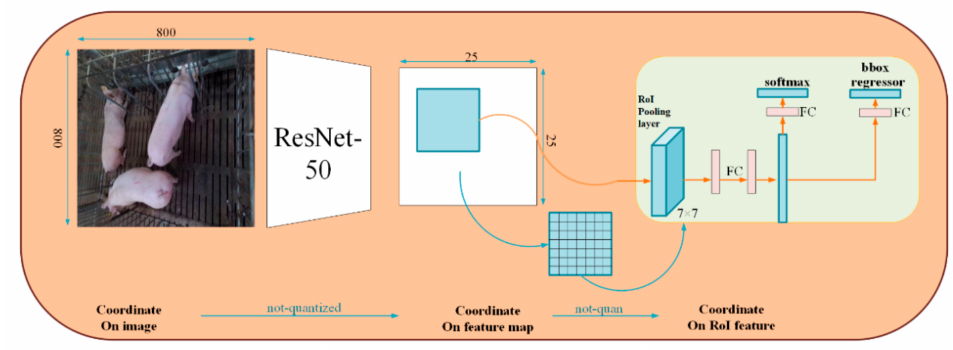
Figure 5. Characteristics of ROI